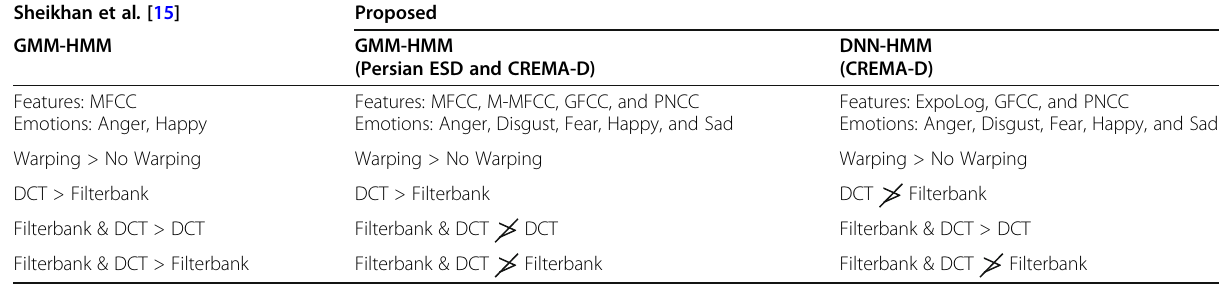
Table 7 The performance comparisons between different frequency warping methods used in the proposed GMM-HMM/DNN- HMM EASR system for the Persian ESD and CREMA-D datasets and the system of Sheikhan et al . [15] for various acoustic